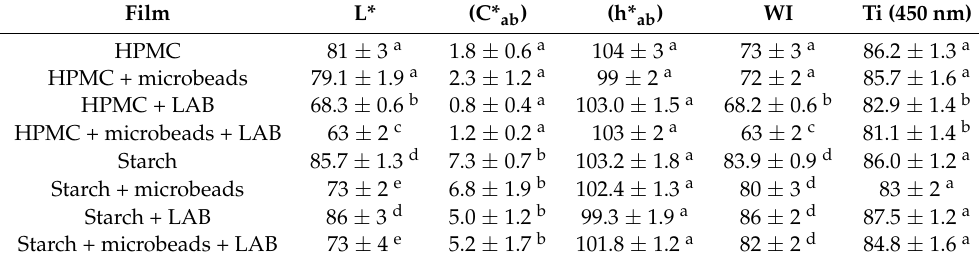
Table 3. Lightness (L*), chrome (C* ab ), hue (h* ab ), whiteness index (WI) and internal transmittance (Ti) of biopolymer films equilibrated at 5 ◦ C and 75% relative humidity. Mean values and standard